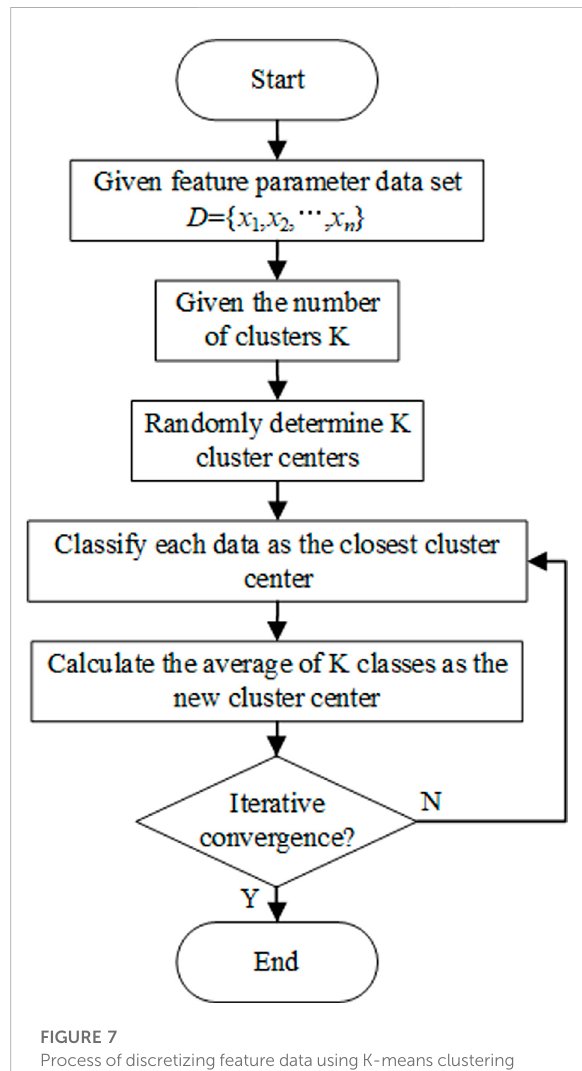
FIGURE 7 Process of discretizing feature data using K-means clustering